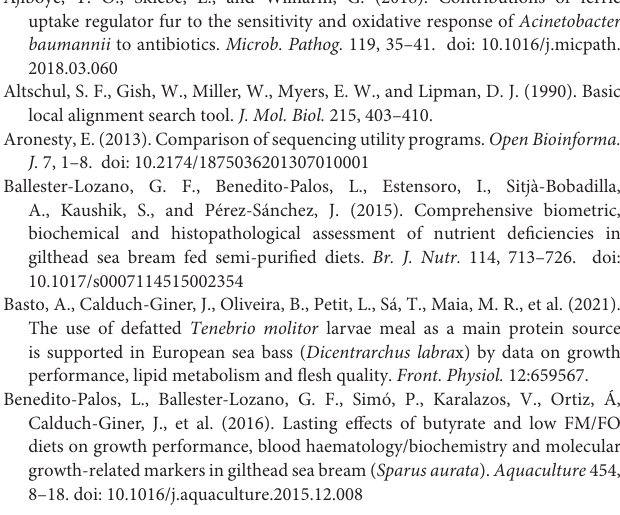
Supplementary Table 2 | Table showing the detailed sequencing data obtained in this